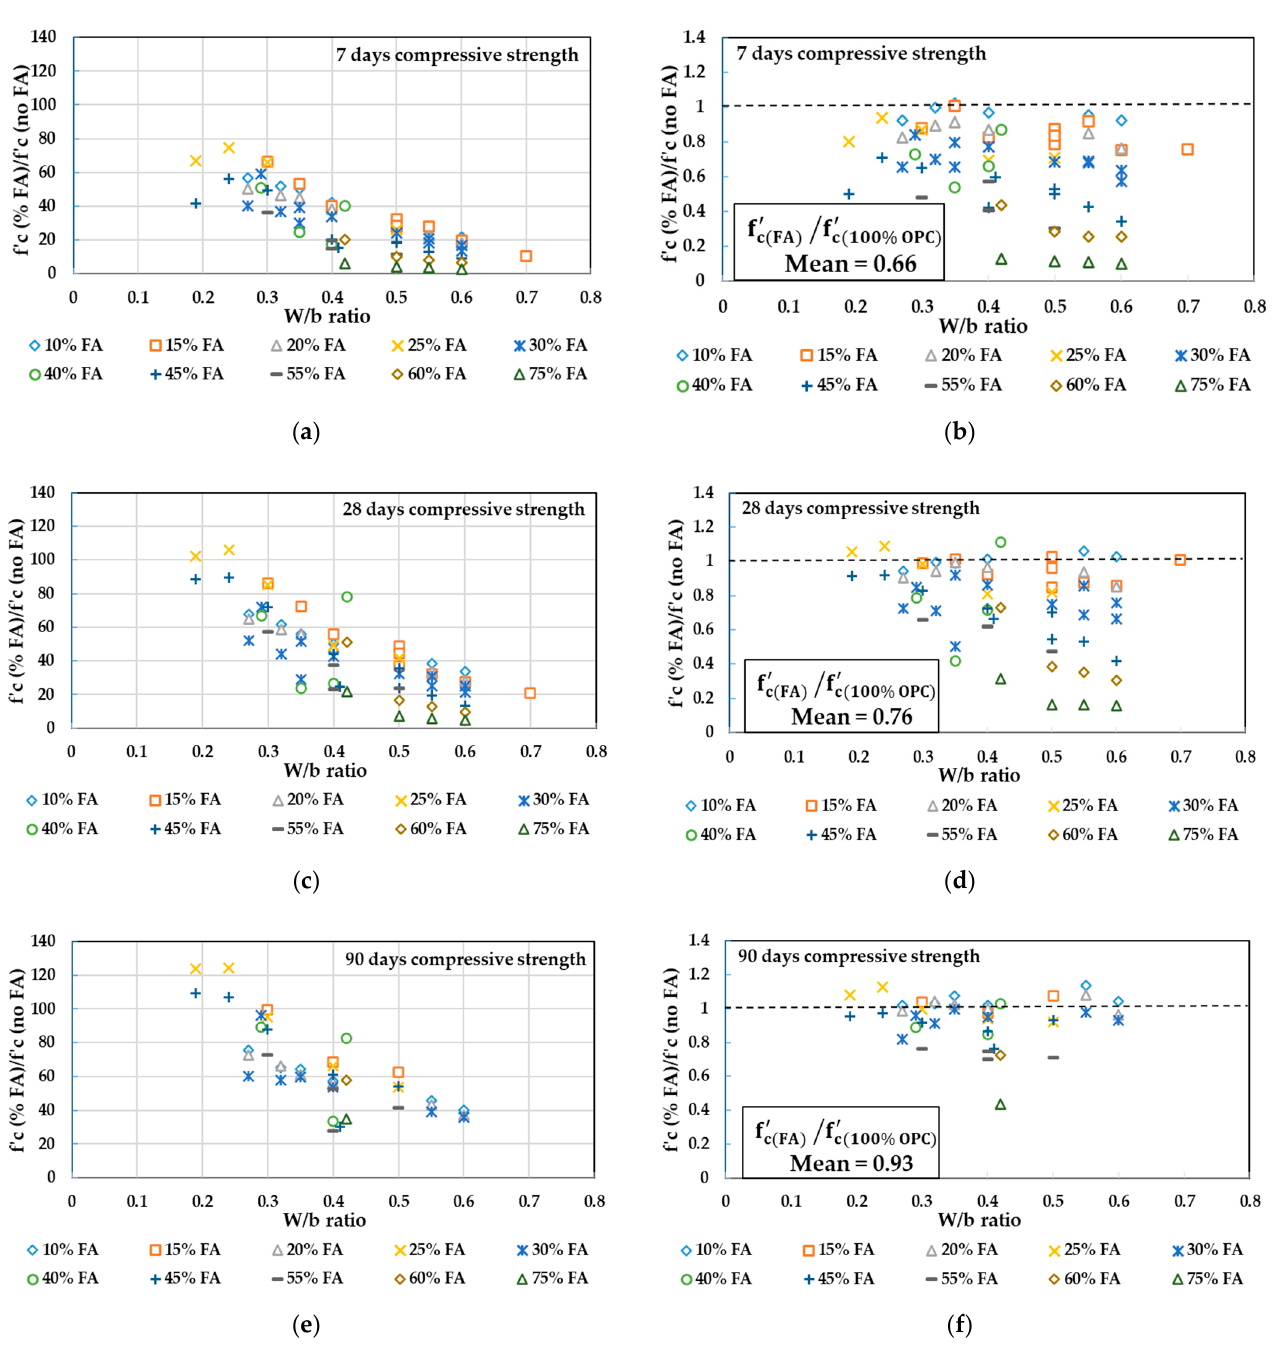
Figure 3. Concrete with Fly ash (FA) as a partially replacing material for cement. Compressive strength vs. W/b ratio at ( a ) 7 days; ( c ) 28 days; ( e ) 90 days. Ratio between compressive strength of concrete with FA to concrete without FA at ( b ) 7 days; ( d ) 28 days; ( f ) 90 days.